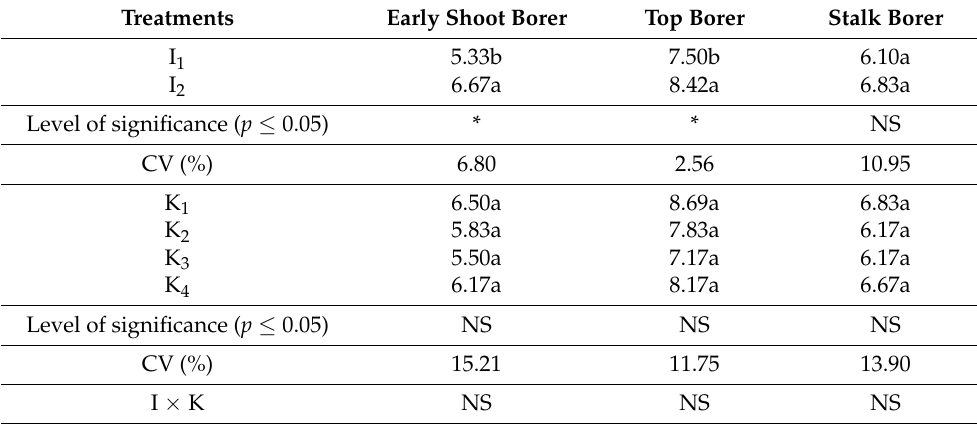
Table 5. Insect pest infestation in sugarcane under different levels of irrigation and potassium.